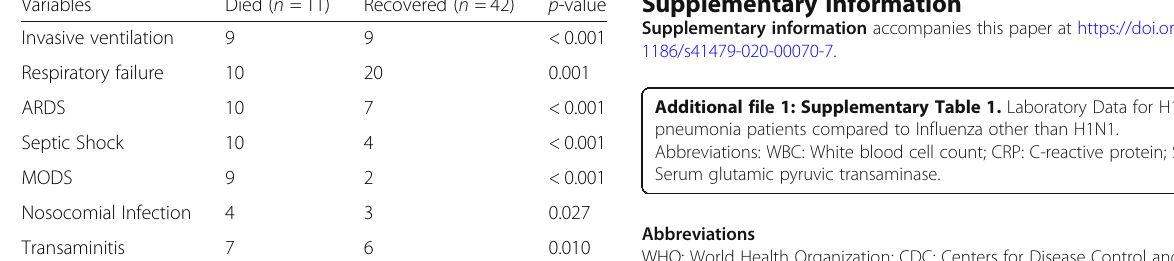
Table 3 Subgroup analysis for mortality in H1N1 pneumonia Variables Died ( n = 11) Recovered ( n = 42) p -value Invasive ventilation